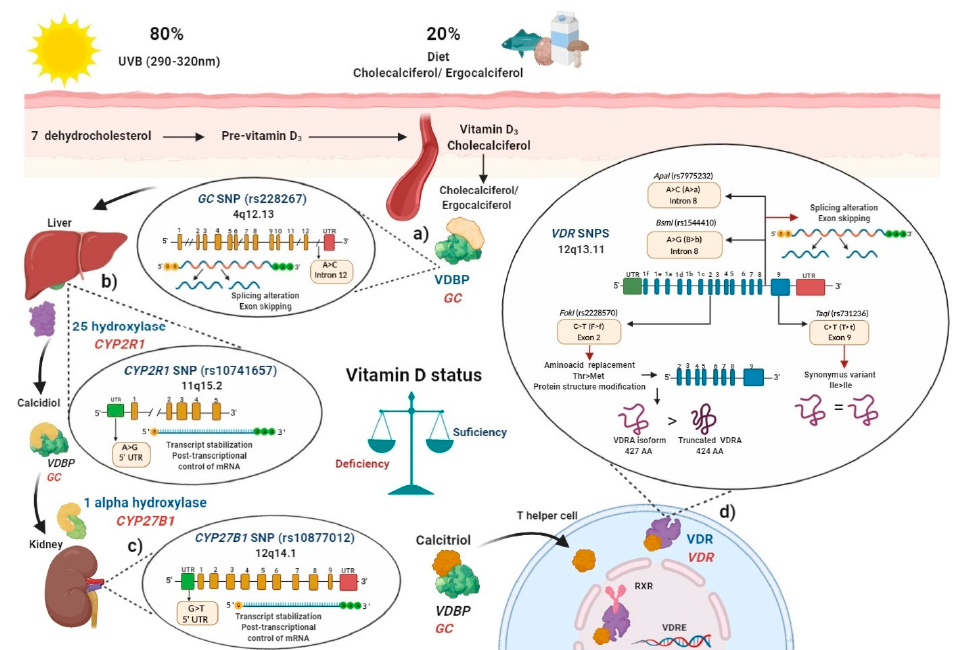
Figure 2. Polymorphisms in main key enzymes and proteins associated with vitamin D metabolism: localization and functional effects: ( a ) Vitamin D binding protein (VDBP) (encoded by GC gene) binds to ergocalciferol/cholecalciferol in order to be transported to the liver; GC (rs2282679) single nucleotide polymorphisms (SNP) due to its location in intron may generate a splicing alteration and exon skipping; ( b ) In the liver, 25 hydroxylase (encoded by CYP2R1 gene) converts ergocalciferol and cholecalciferol to calcidiol and then calcidiol binds to VDBP to be transported to the kidney; CYP2R1 (rs10741657)SNP located on the 5 ′ untranslated region (UTR) region may affect the transcript stabilization and the post-transcriptional control; ( c ) In the kidney, calcidiol is converted to calcitriol by the enzyme 1 alpha hydroxylase (encoded by the CYP27B1 gene); CYP27B1 (rs10877012) SNP located on 5 ′ UTR may affect the transcript stabilization and the post-transcriptional control of mRNA; ( d ) After calcitriol enters target cells and binds to vitamin D receptor (VDR) (encoded by VDR gene). Then, the VDR-calcitriol complex in the cytosol is translocated to the nucleus, where it binds to retinoid X receptor (RXR) to form a heterodimer, which interacts with vitamin D response element (VDRE) in vitamin D target genes, i.e., in T helper (Th) lymphocytes to suppress IL-17A or activate FOXP3. Mainly four SNPs have been described in the VDR gene: the FokI (rs2228570) located on exon 2, which generates a non-synonymous polymorphism with a change of C > T (also called F > f) and this results in a change of threonine to methionine. The presence of the restriction site FokI C allele (F allele), generates a new start codon (ATG) 9 bp after of the common starting site, which translate to an shorter truncated VDR protein of 424 amino acids with more transactivation capacity as a transcription factor than the wild type full-length VDR A isoform (VDRA) of 427 amino acids; the BsmI (rs1544410) located on intron 8 presents a change of A > G (also called B > b), could affect messenger ribonucleic acid (mRNA) stability and the gene expression of VDR , and also it could generate an alteration in the splice sites for mRNA transcription or a change in the intron regulatory elements of VDR ; ApaI (rs7975232) located on intron 8 of VDR presents a change of A > C (also called A > a), does not change the amino acid sequence of the VDR protein, therefore could affect mRNA stability and the gene expression of VDR ; TaqI (rs731236) is located on the exon 9 of VDR , presents a change of C > T (also called T > t) and generates a synonymous change of the isoleucine amino acid in the coding sequence, therefore it does not change the encoded protein, but it could influence the stability of the mRNA. All these SNPs are related to modulating de vitamin D serum status in health and disease. Ile: isoleucine; Thr: threonine; Met: methionine VDBP: vitamin D binding protein; VDR: vitamin D receptor; RXR: retinoid X receptor; VDRE: vitamin D response elements; UTR: untranslated region; THEM4: thioesterase superfamily member 4; Th: T helper lymphocyte; VDRA: wild type full-length VDR A